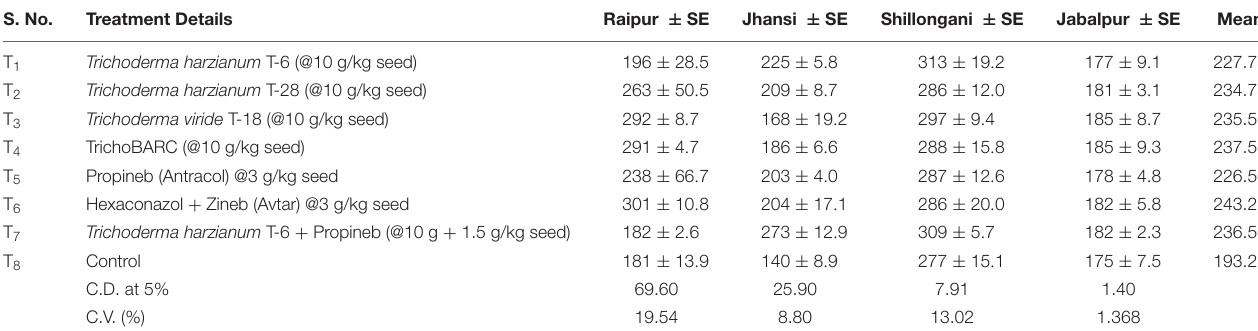
TABLE 2B | Evaluation of new stains of Trichoderma along with fungicides for the management of collar rot of chickpea (2017–2018) – Disease incidence (%). S. No.